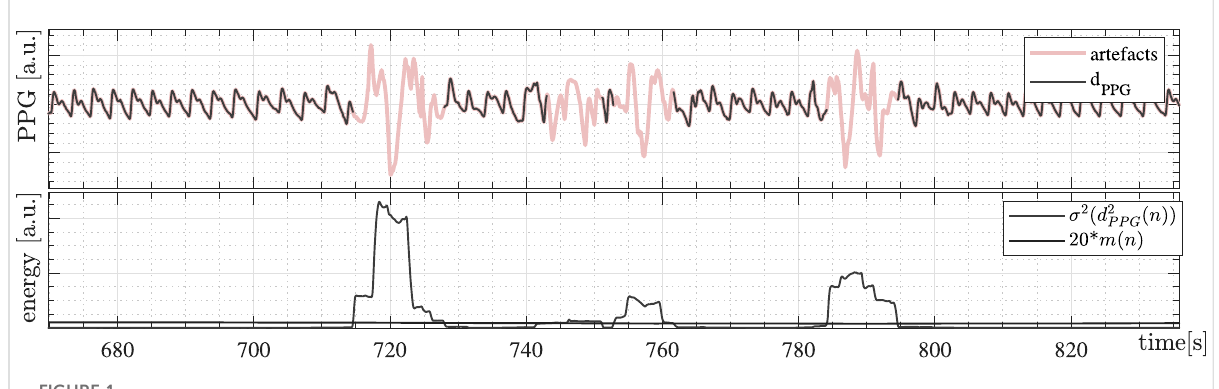
FIGURE 1 PPGartifactdetectionbasedontheenergyofthesignal.DetectedPPGartifactsareinredatthetop.Theestimatedenergy, σ 2 ( d 2 PPG ( n )) ,andthe decision criteria, 20* m ( n ), are plotted at the bottom.